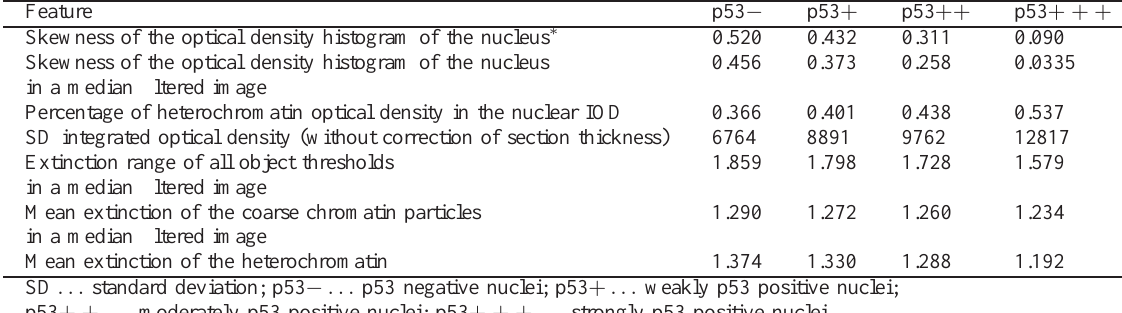
Table 8 Significant differences in the nuclear subpopulations with different p53 expression in the euploid (di- and tetraploid) p53 positive tumours ( p < 0 . 05) Feature p53 − p53 + p53 ++ p53 + + + Skewness of the optical density histogram of the nucleus